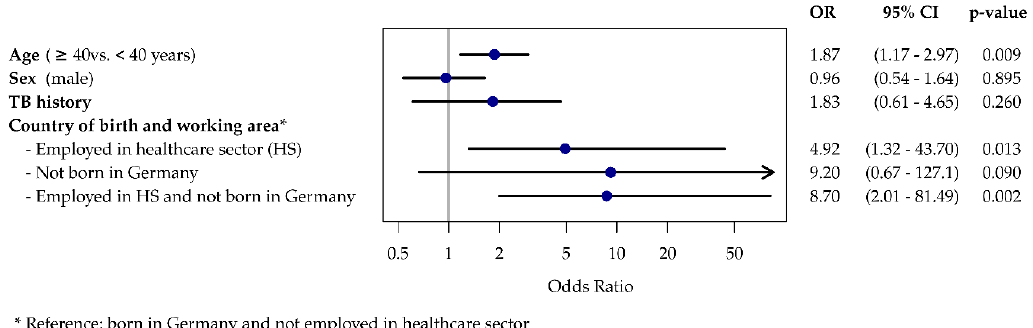
Figure 3. Forest plot for the results of the logistic regression model with IGRA test positive as the dependent variable. The variables age, sex, TB history and all four possible combinations of country of birth and employment as HWs are depicted as independent variables.